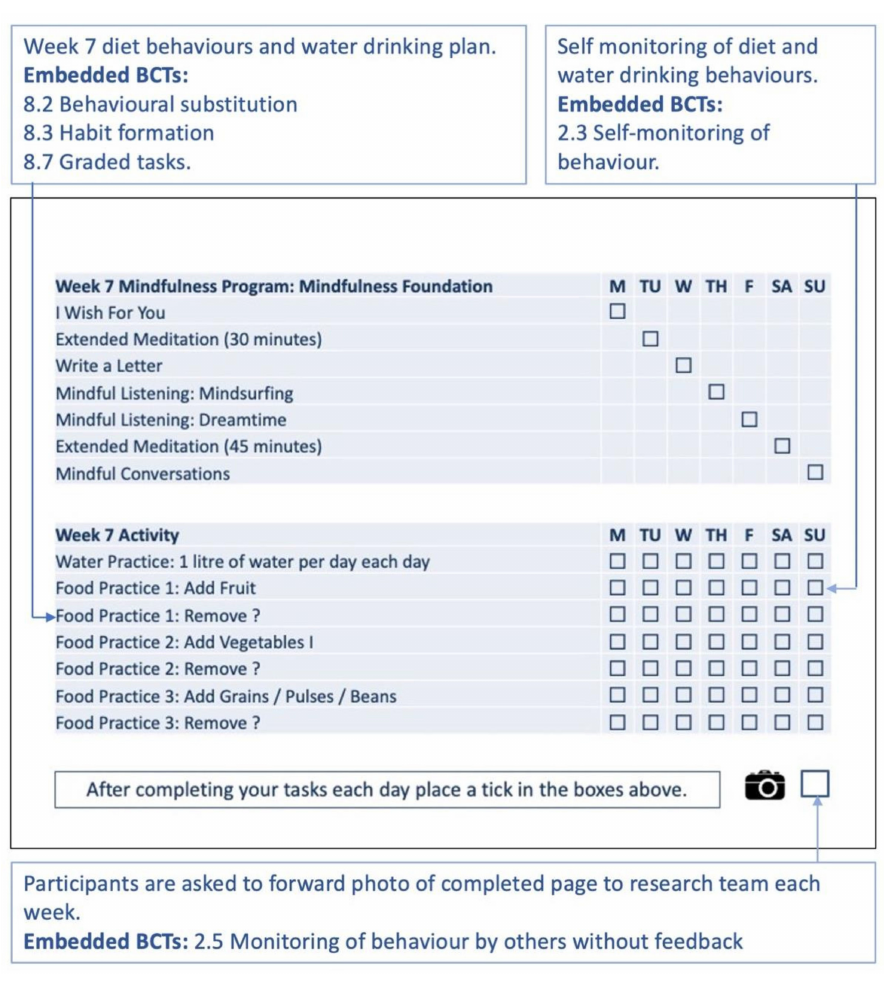
Figure 11. Week 7 monitoring page is part of one A4 page in the planner. The text in the blue boxes is explanatory text and not part of the planner. BCTs used refer to Michie et al. taxonomy